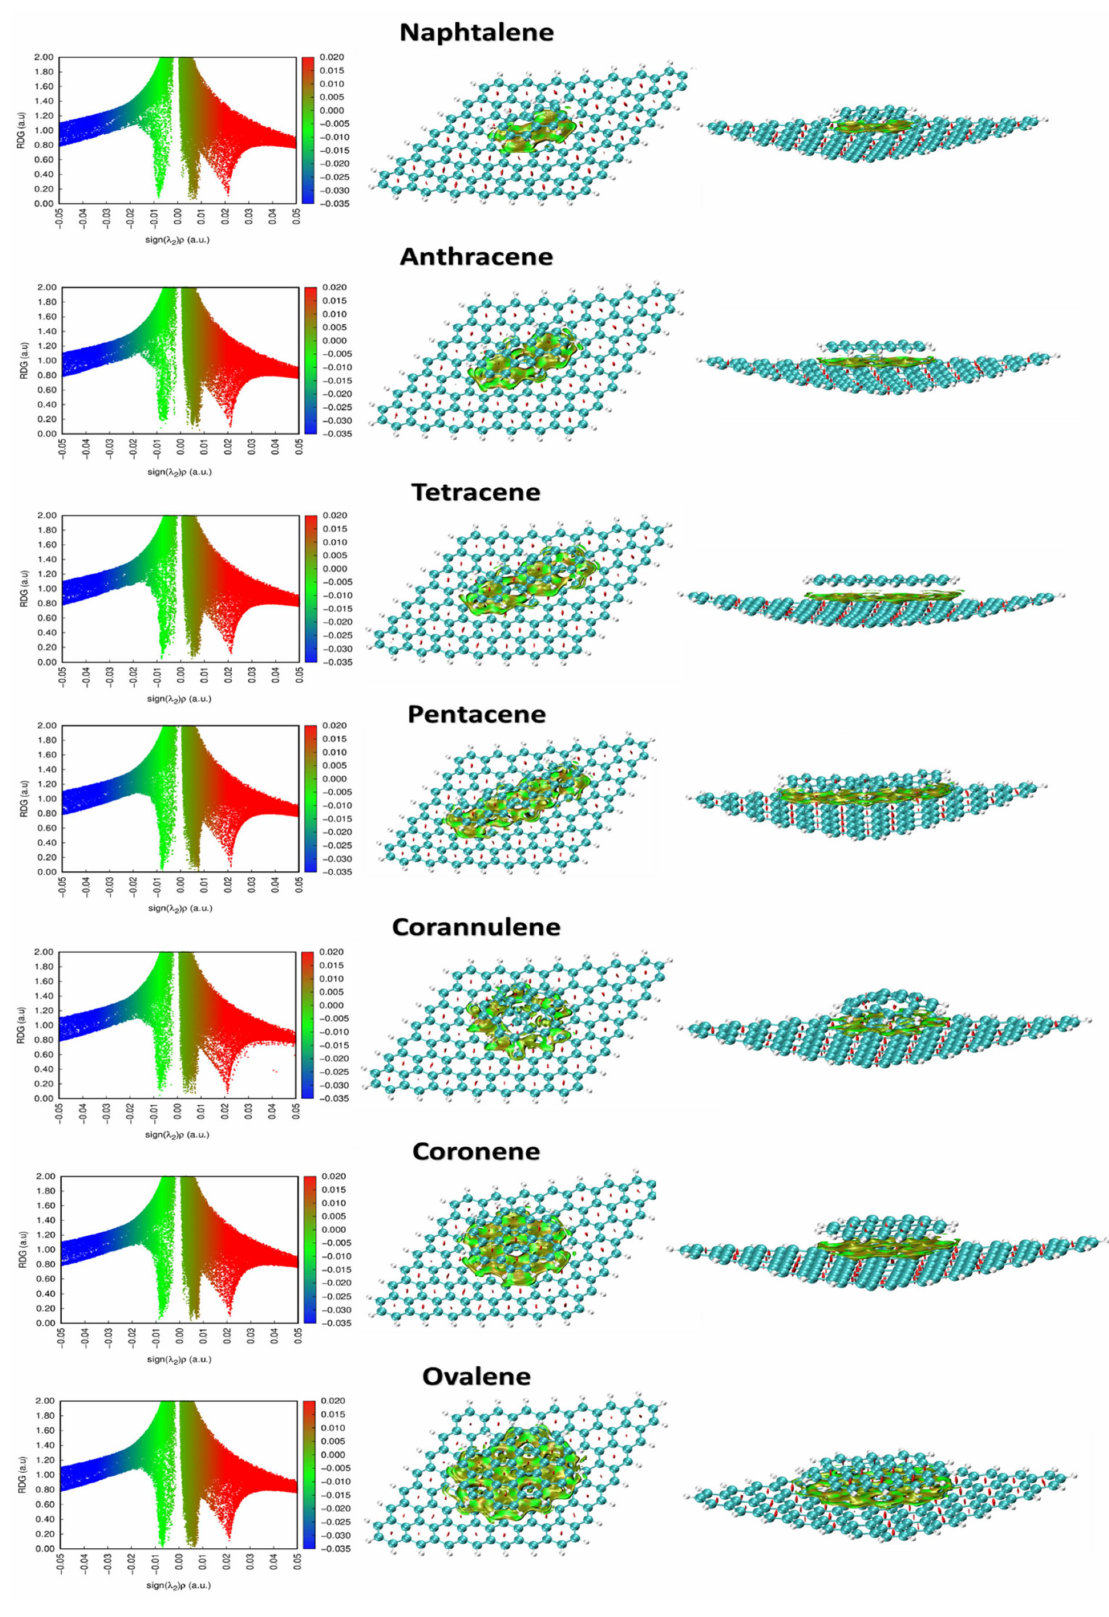
Figure 4. Surfaces of NCI contacts and the plot of RDG vs. sign( λ ) ρ van der Waals interactions between PAH molecules and the G